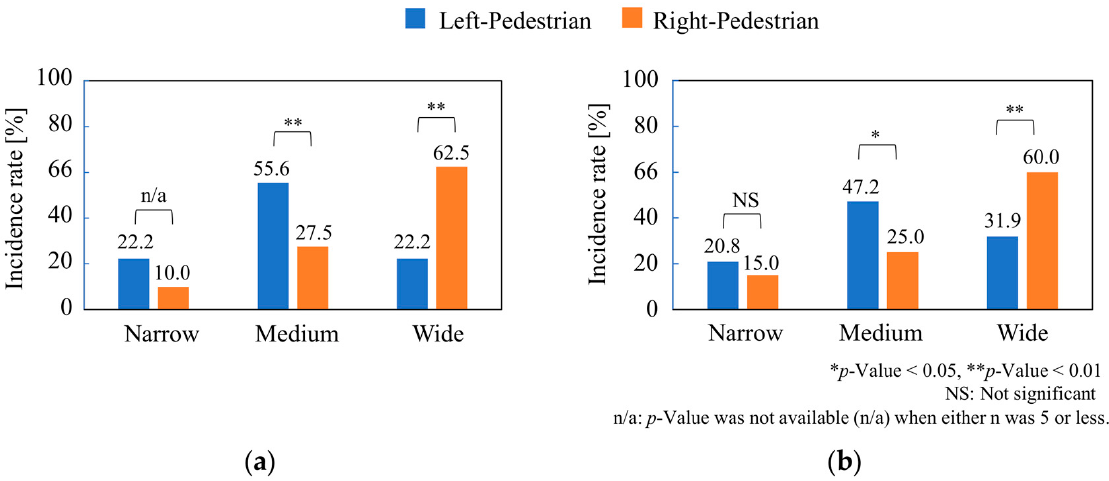
Figure 5. Incidence rate according to road width to/through the intersection in the presence of Left- Pedestrian ( n = 72) and Right-Pedestrian ( n = 40): ( a ) to the intersection; ( b ) through the intersection. For the road width through the intersection, Left-Pedestrian had the highest rate of incidents on medium roads (47.2%), followed by wide roads (31.9%) and narrow roads (20.8%). Right-Pedestrians had the highest rate of incidents on wide roads (60.0%), followed by medium roads (25.0%) and narrow roads (15.0%). The rate on medium roads for Left-Pedestrians (47.2%) was significantly higher than that for Right-Pedestrians (25.0%), whereas that on wide roads for Left-Pedestrians (31.9%) was significantly lower than that for Right-Pedestrians (60.0%).